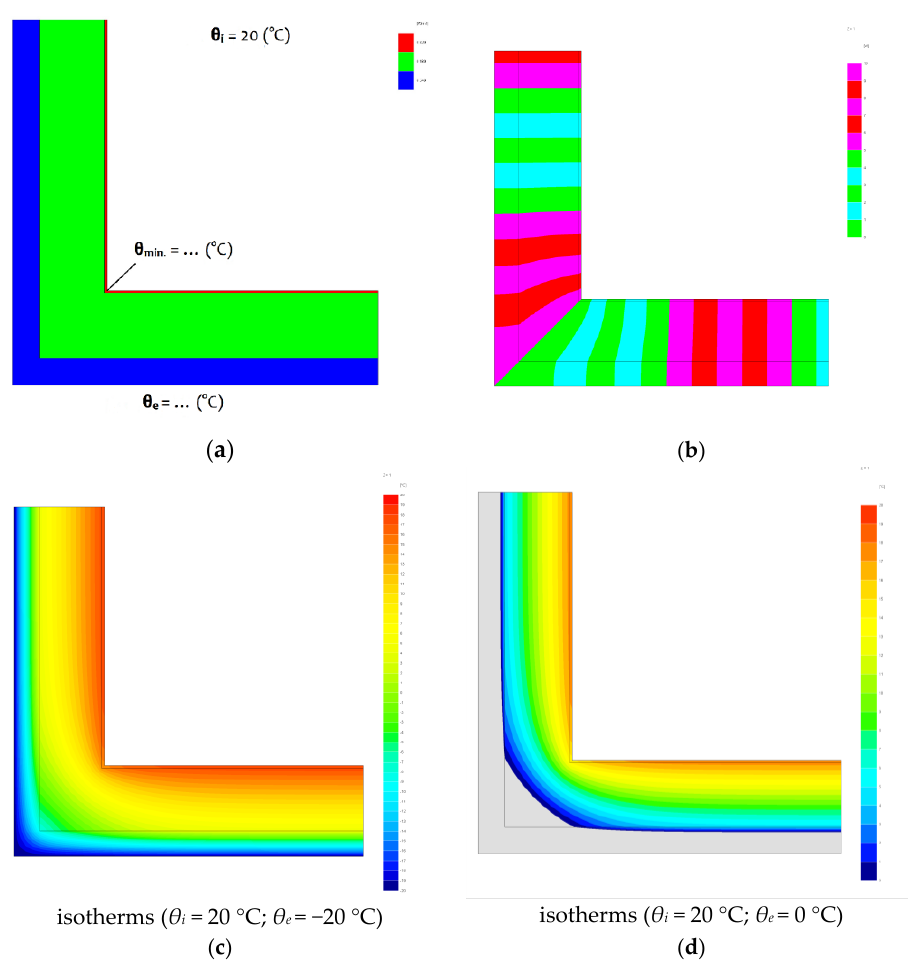
Figure 5. Graphic representation of the simulation results of numerical calculations for the corner of external walls: ( a ) Calculation model; ( b ) Heat flux lines; ( c), ( d ) Temperature distribution. Table 13. Temperature at the corners of external walls.